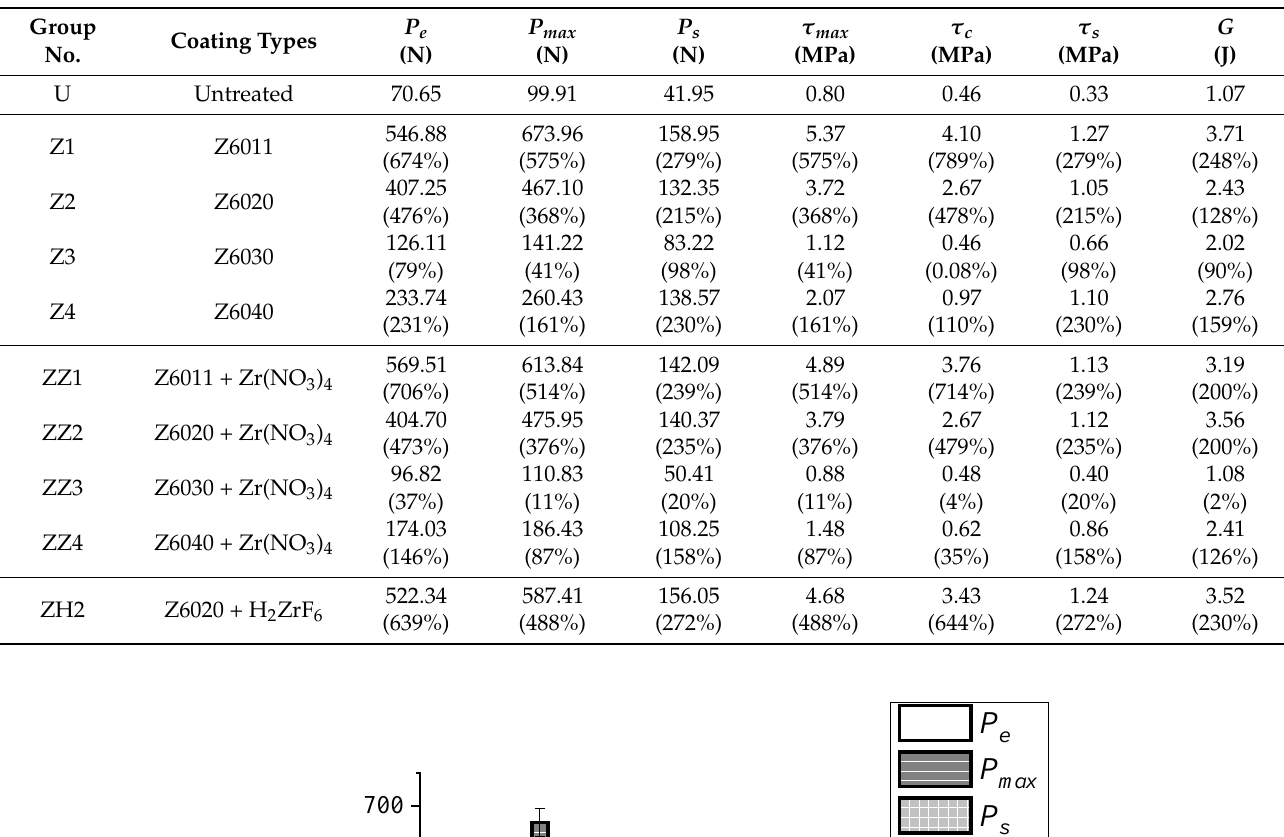
Table 1. Major parameters extracted from the pullout tests.